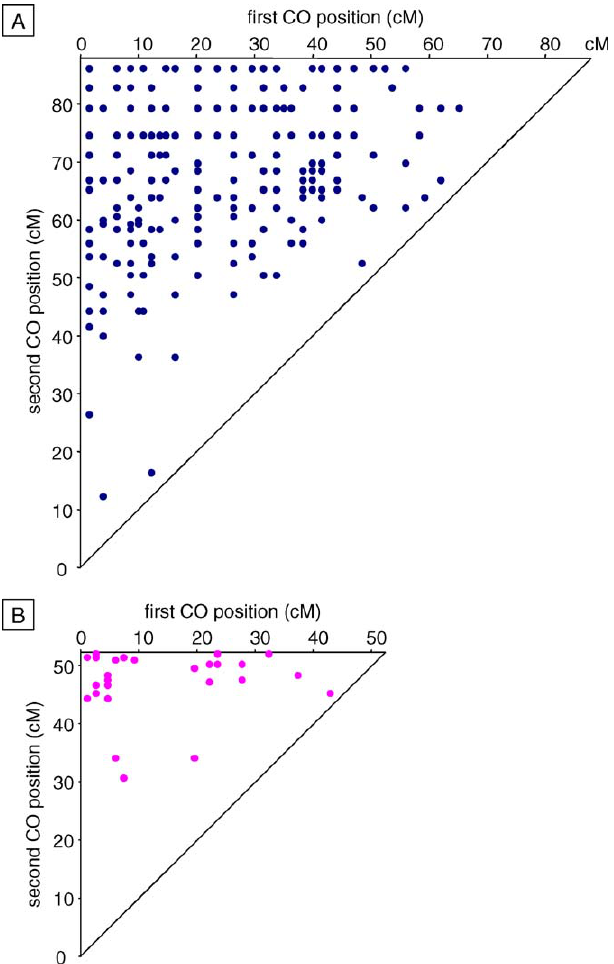
Figure 4. Double-CO Locations on (A) Male and (B) Female Chromo- some 4 All double-COs on chromosomes harboring exactly two COs were plotted in two-dimensional graphs. The x and y axis values indicate the genetic position (relative to the nucleolar organizing region) of the first and the second CO, respectively. The diagonal line and the upper left corner correspond to minimal (null) and maximal (chromosome-wide) inter-COs distances,